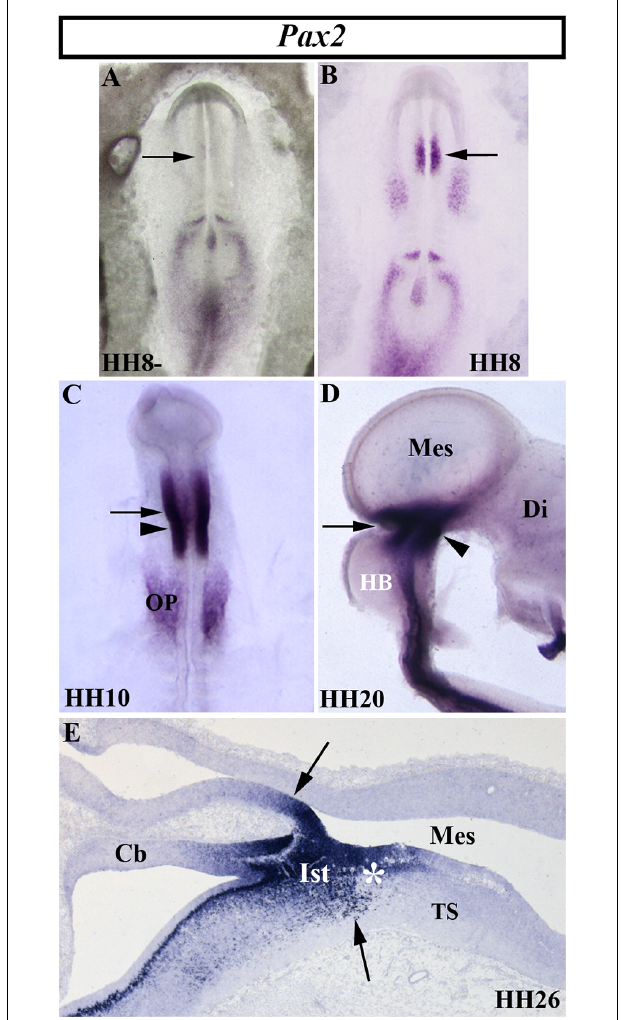
FIGURE 5 | Spatial and temporal distribution of Pax2 transcripts in the chick developing MH domain at different developmental stages. Single in situ hybridization performed in whole-mount (A–D) and in sagittal sections (E) . In the presumptive MH domain, Pax2 expression starts to be detected at stage HH8, but not before (arrows in A,B ). At stages HH10, HH20, and HH26, Pax2 transcripts are detected on both sides of the MH boundary (arrows in C,E ). The arrowheads in (C) and (D) point to the mes/met constriction. At stage HH26 (E) , Pax2 expression is observed in the isthmic (Its) and pre-isthmic (asterisk in E ) domains. Cb, cerebellum; Di, diencephalon; HB, hindbrain; Mes, mesencephalon; OP, otic placode; TS, torus semicircularis. From Hidalgo-Sánchez et al. (1999a,